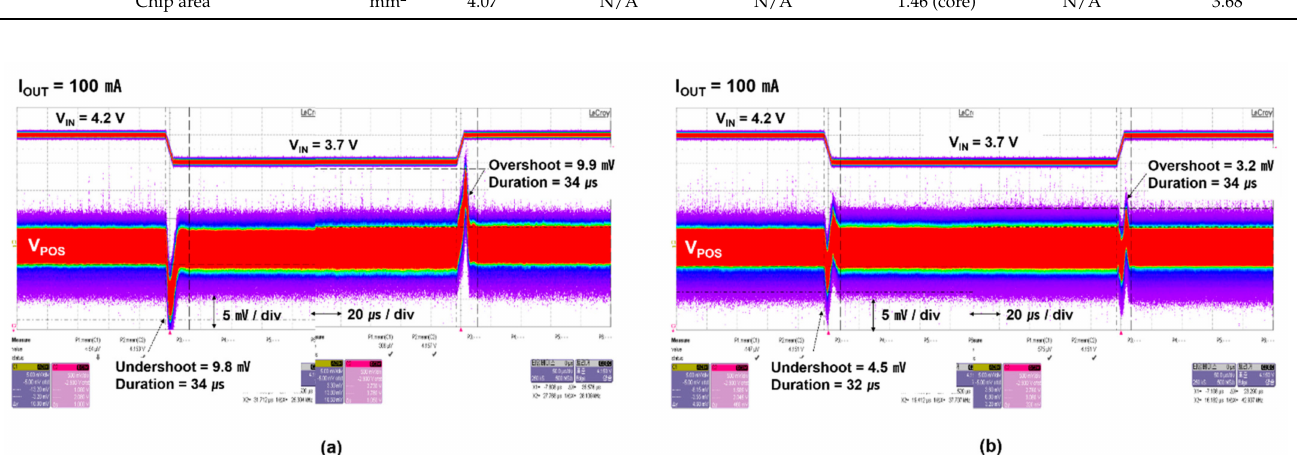
Figure 12. Measurement results of output ripples of V POS using the proposed IVVRC: ( a ) without IVVRC; ( b ) with IVVRC. Figure 14 shows the load transient waveforms. For load transient measurements, the ripple and the duration time of V POS and V NEG were measured when the output current was changed from 0 mA to 60 mA with a slope of 5 µ s, and back to 0 mA. For the proposed V NEG using PWM–SPWM dual mode, the overshoot was 21 mV and the duration time was 14 µ s, as shown in Figure 14a. In case of the V NEG using PWM–PSM dual mode in [4], the overshoot was 24 mV and the duration time was 24 µ s, as shown in Figure 14b. Therefore, the overshoot of our V NEG was 3 mV smaller than that of [4], and the duration time was 10 µ s faster than [4]. This may be the result of the PWM–SPWM dual-mode method that only generated set pulses through VCO, based on PWM and the reset circuit that generated a constant clock of 1.5 MHz operating together, which allowed the mode transition based on the increase in the output current to reach 1.5 MHz in the PWM mode without time